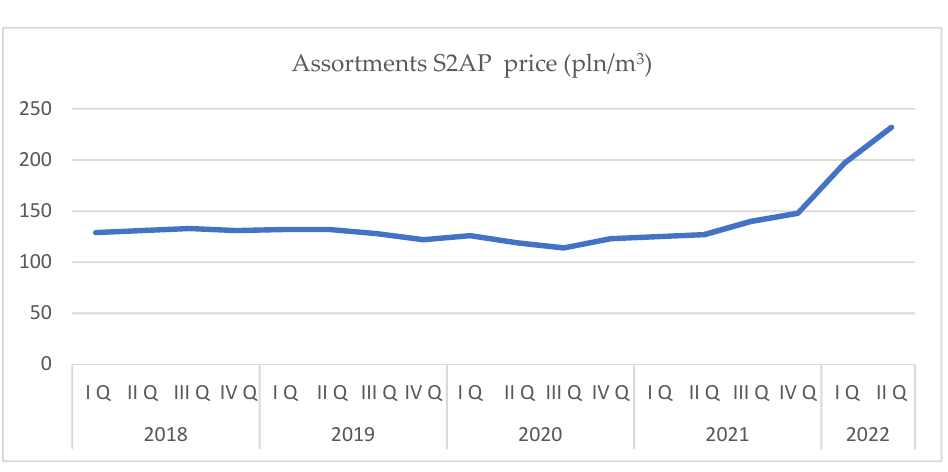
Figure 5. Price forecast for the M2 assortment in Q3 of 2022, Q4 of 2022, and Q1 of 2023. Source: Own elaboration based on data obtained from the State Forests IT System (SILP). * estimated value 80% and 95% confidence intervals.